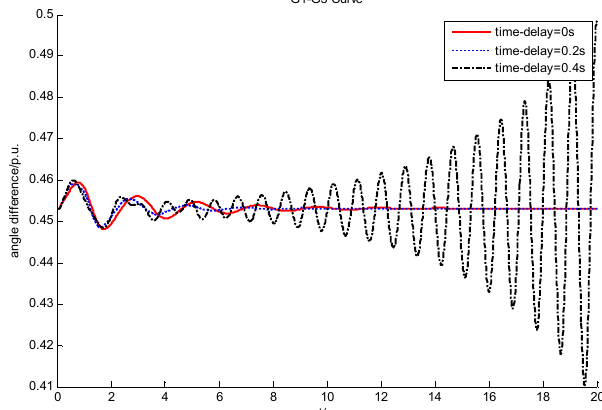
Figure 8. G1–G3 angle difference curves with different time-delays.